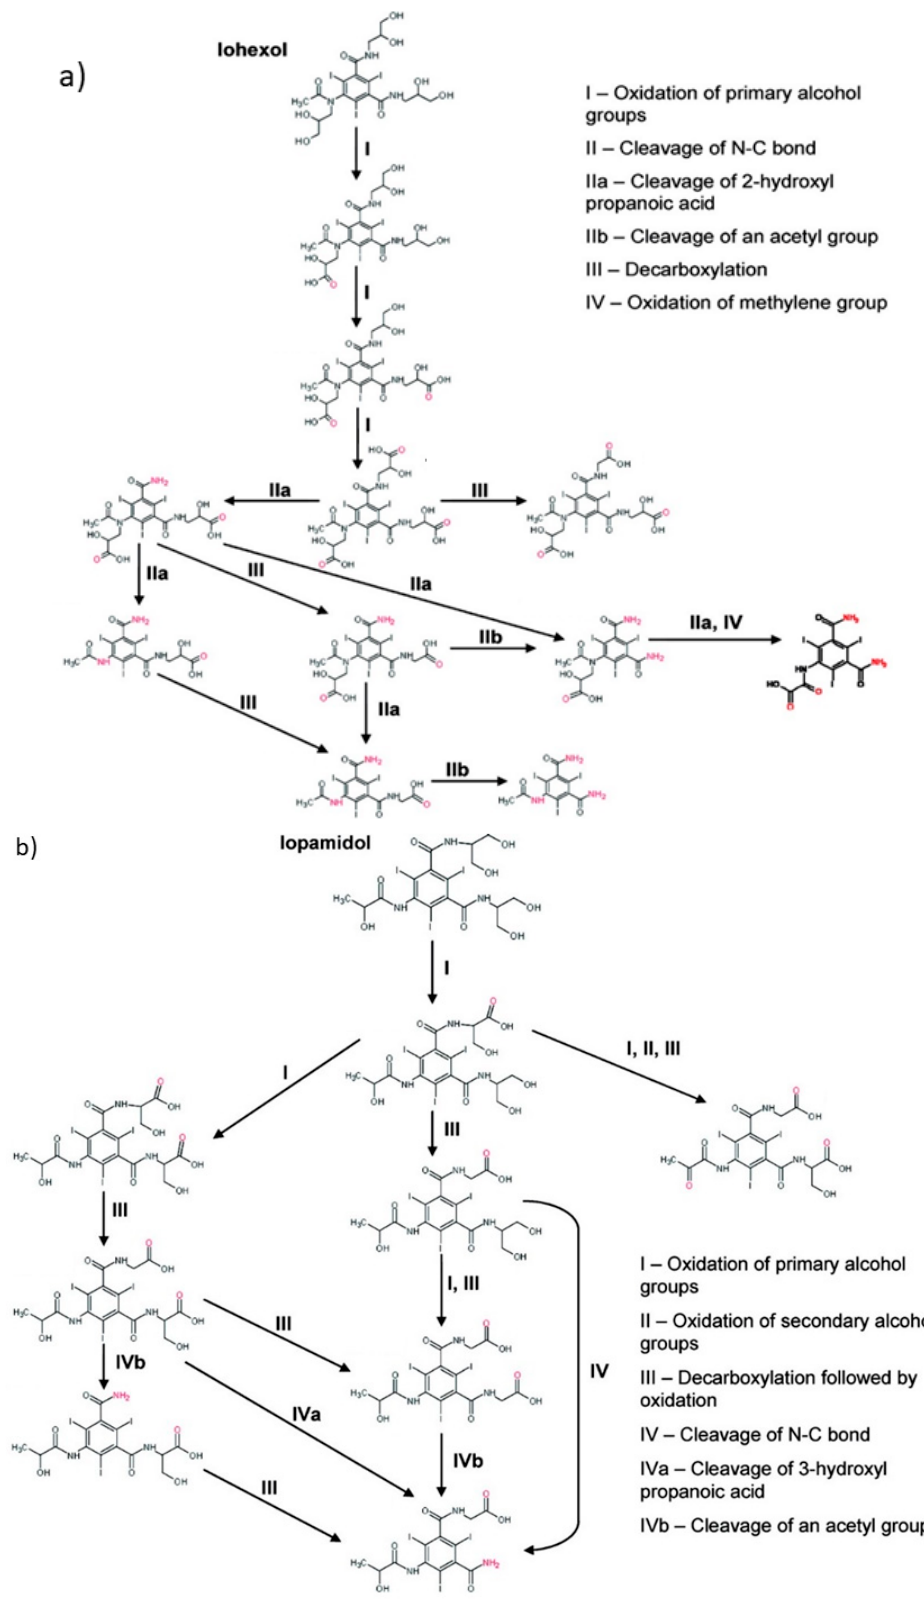
Figure 1. Proposed microbial transformation pathway (TP: transformation products) of ( a ) iohexol and ( b ) iopamidol [52] Reprinted with permission from ref [52]. Copyright 2010 American Chemical Society.